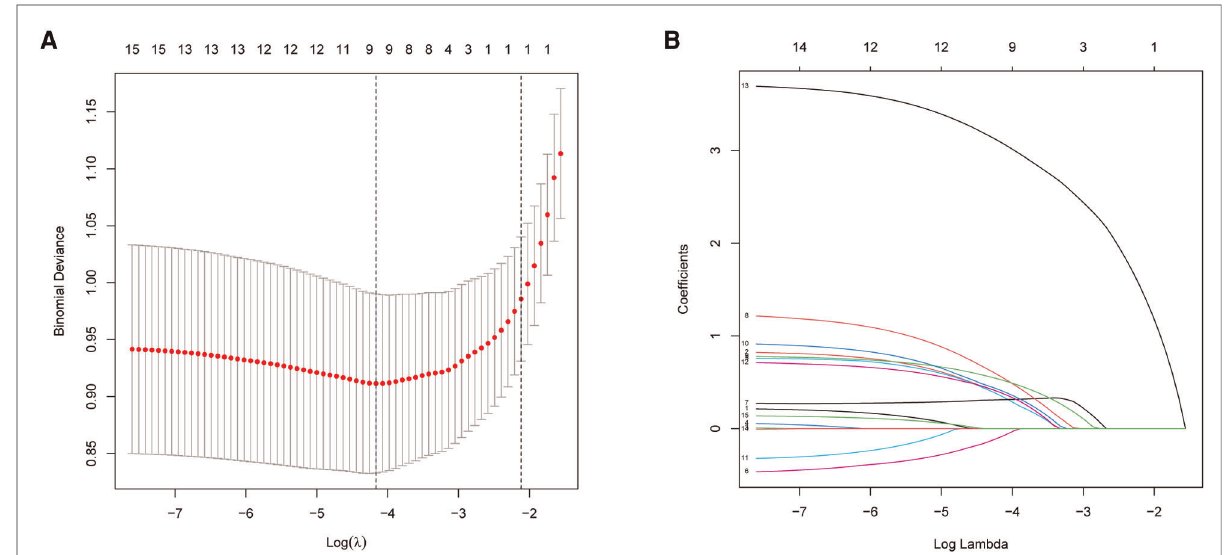
FIGURE 2 Demographic and clinical feature selection using the LASSO binary logistic regression model. ( A ) Optimal parameter (lambda) selection in the LASSO model used 5-fold cross-validation via minimum criteria. The partial likelihood deviance (binomial deviance) curve was plotted versus log (lambda). Dotted vertical lines were drawn at the optimal values by using the minimum criteria and the 1 SE of the minimum criteria (the 1-SE criteria). ( B ) LASSO coef fi cient pro fi les of the 15 features. A coef fi cient pro fi le plot was produced against the log (lambda) sequence. A vertical line was drawn at the value selected using 5-fold cross-validation, where optimal lambda resulted in fi ve features with nonzero coef fi cients. LASSO, least absolute shrinkage and selection operator; SE, standard error.